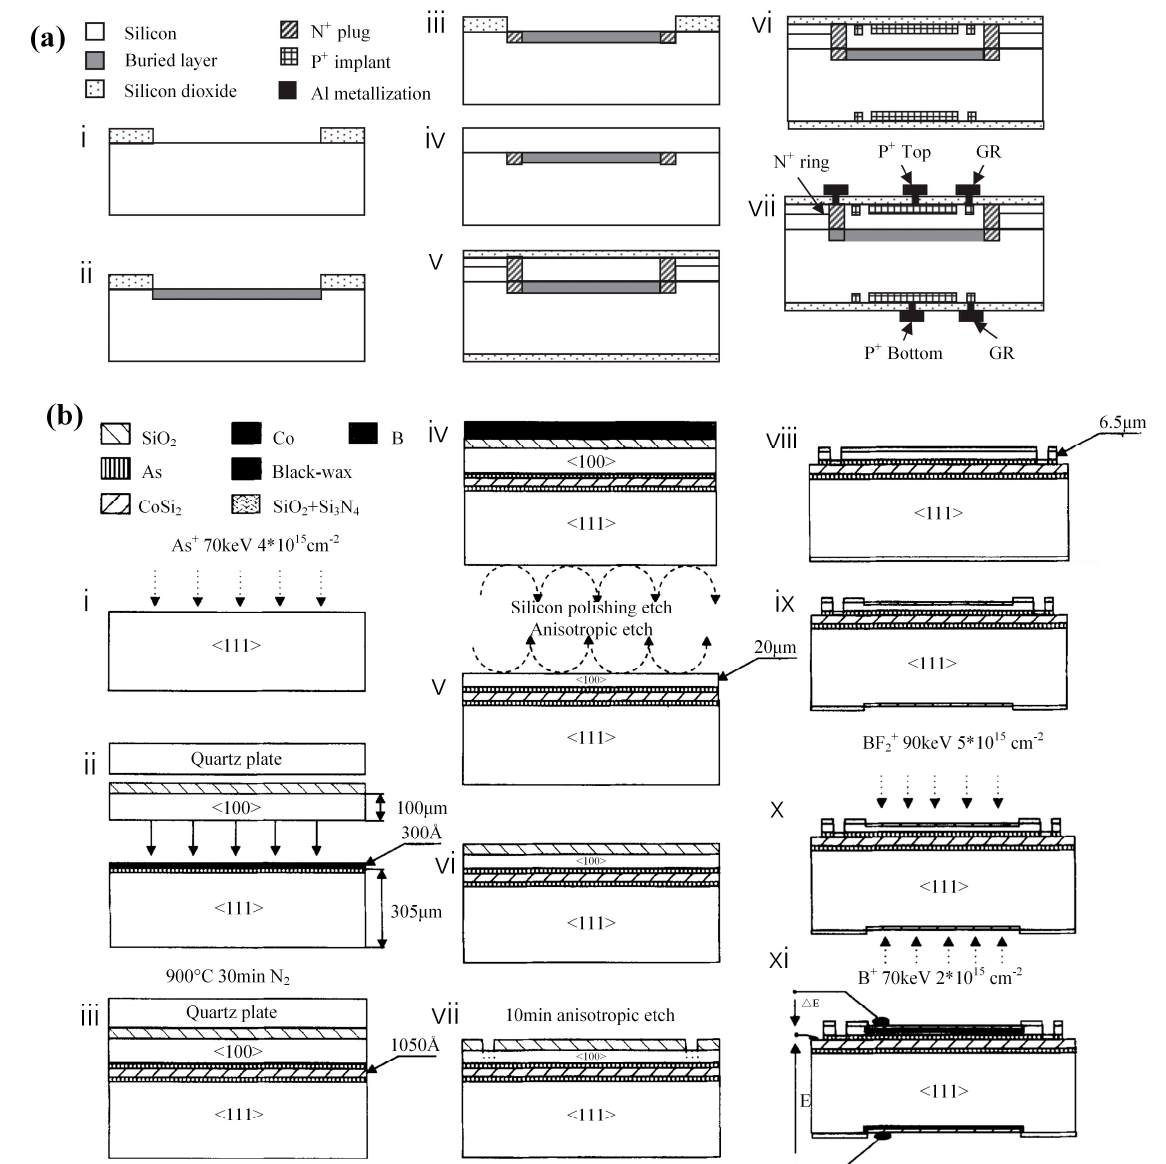
Figure 3. Process flow diagram of integrated silicon PIN radiation detector based on ( a ) epitaxial growth [18] and ( b ) cobalt silicide as the conductive buried layer [11].